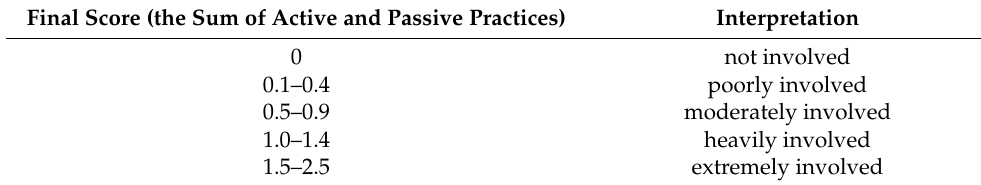
Table 3. Degree of involvement in environmental practices. Final Score (the Sum of Active and Passive